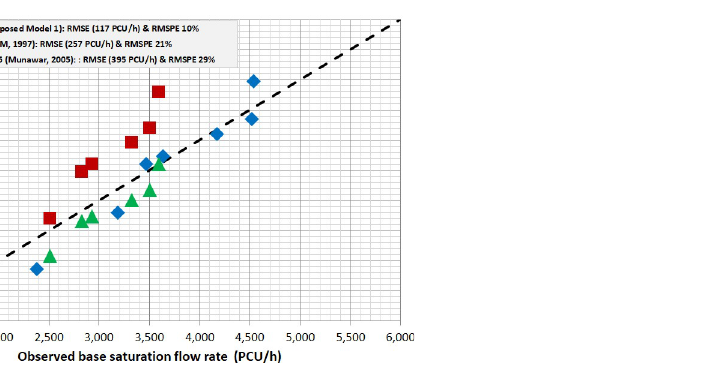
Fig 7. Validation plot among base saturation flow rate model